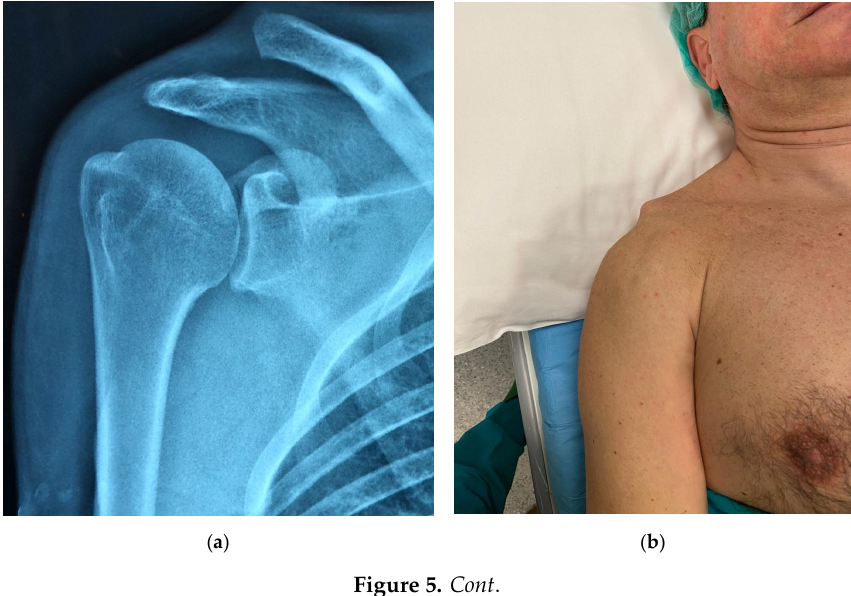
( d ) Figure 5. A clinical and radiological pre- and post-operative example. ( a ) preoperative x-ray, ( b ) clinical visualization of dislocation, ( c ) postoperative 3 months x-ray, ( d ) post-operative 3 months consultation. 4. Discussion A variety of surgical techniques have been described in the literature for the treatment of grade III injuries which appear heterogeneous, and hence respond differently to nonoperative treatment; as a result, there is controversy regarding the treatment of these injuries [6,32] (Table 1).